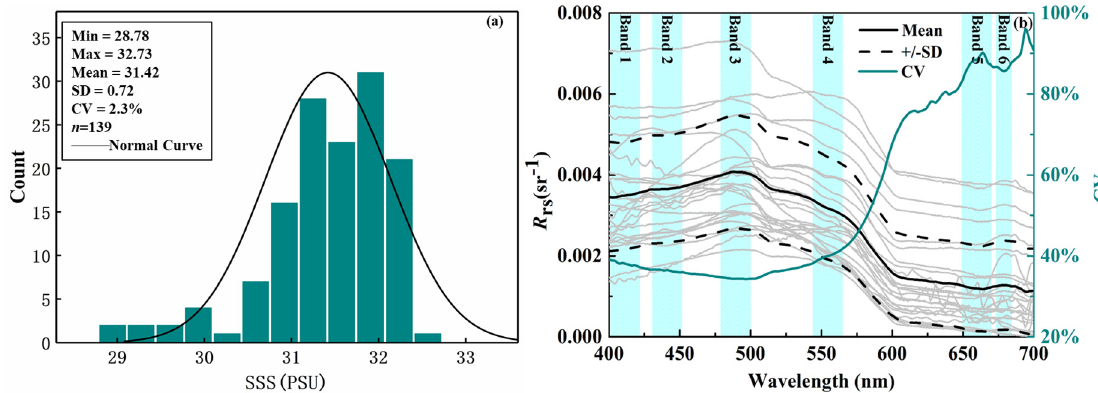
Figure 2. ( a ) Histogram of sea surface salinity (SSS) collected from the SYS. The black line represents a normal distribution curve; ( b ) Spectral shapes of the measured Rrs( λ ) overlaid by the locations of 6 Geostationary Ocean Color Imager (GOCI) channels (blue bars). The green line represents the coefficient of variation of Rrs( λ ). The solid black line represents the mean of Rrs( λ ) spectra and the black dotted line is the mean plus or minus the standard deviation.